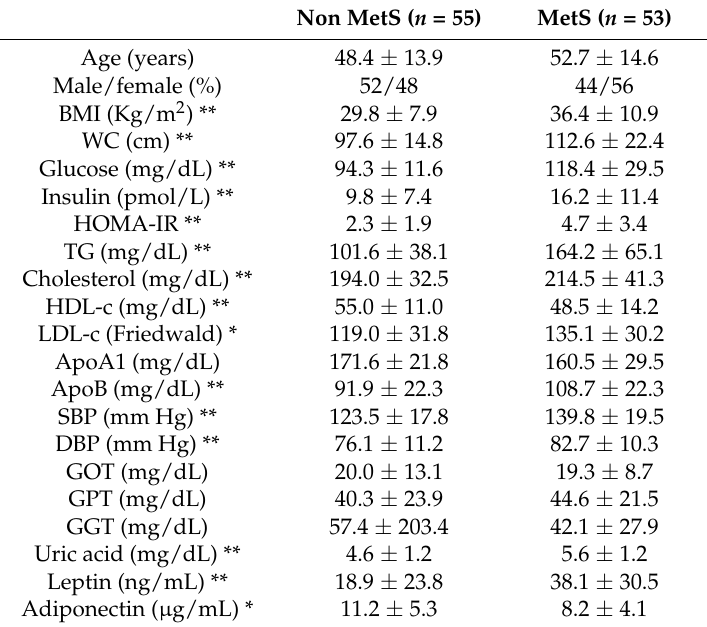
Table 1. Biochemical and anthropometric parameters in non-metabolic syndrome subjects (Non MetS) and metabolic syndrome subjects (MetS).